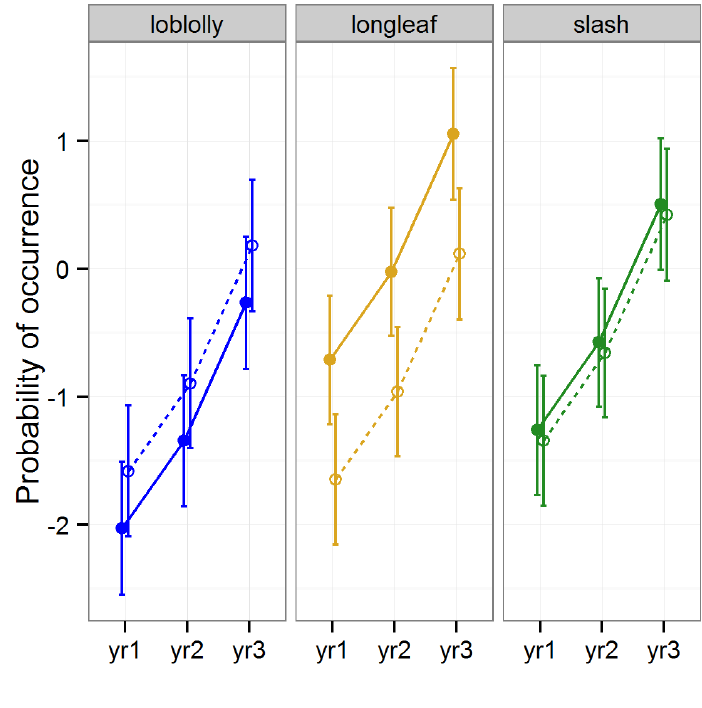
from the most parsimonious model based on log-likelihood ratio tests; raked stands are displayed with open circles and dashed lines, intact stands with solid circles and lines; 2008 as yr1, 2009 as yr2 and 2010 as